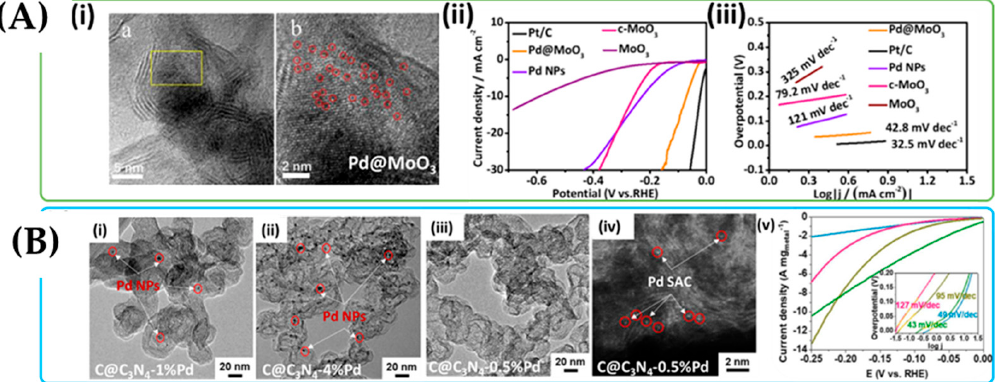
Figure 27. ( A ) ( i ) HRTEM images of Pd@MoO 3 where the Pd atoms are marked with red circles dispersed in the MoO 3 sheets; ( ii , iii ) LSV curves and Tafel plots respectively for Pd@MoO 3 , c-MoO 3 , MoO 3 , Pd NPs and Pt/C catalysts ( a ) and ( b ) TEM images in different scale. ( B ) ( i , ii ) TEM images of C@C 3 N 4 -1%Pd (left) and C@C 3 N 4 -4%Pd (right). With red circles, we mark the Pd NPs, which are formed at these relatively high concentrations of noble metal; ( iii , iv ) TEM and HAADF-STEM images of C@C 3 N 4 -0.5%Pd where no particles were observed in the TEM images whilst many bright dots were observed in the HAADF-STEM image; ( v ) Hydrogen evolution reaction results performed by linear sweep voltammetry in Ar-saturated 0.1 M HClO 4 solution on 20% Pd/C (blue), C@C 3 N 4 -4%Pd (green), C@C 3 N 4 -1%Pd (mustard), and C@C 3 N 4 -0.5%Pd (magenta). The inset shows HER Tafel slope of the catalysis ad ο pted with permission from [121].